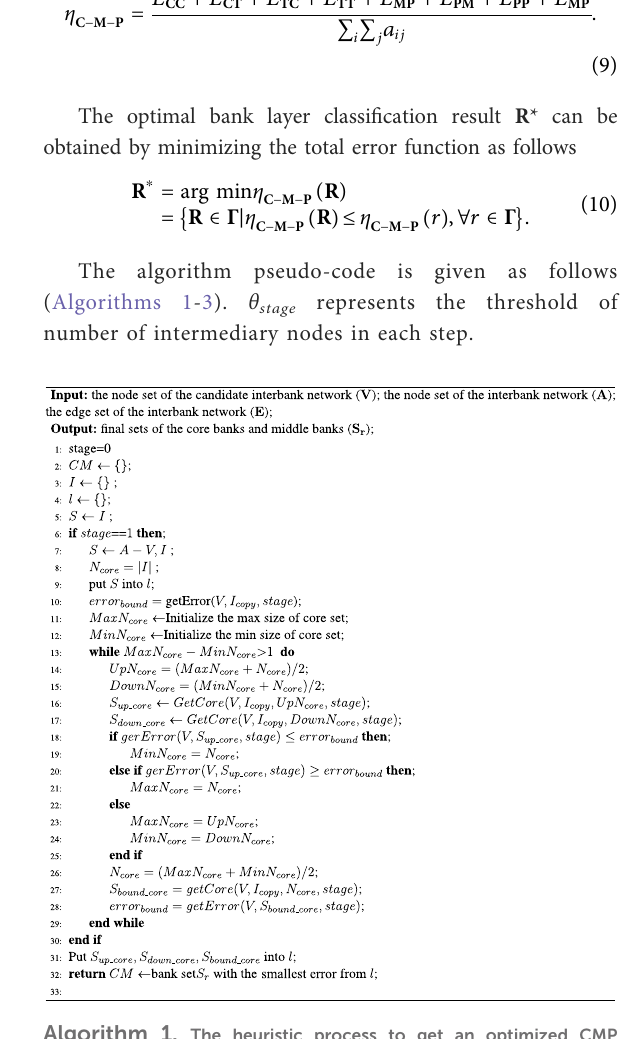
Algorithm 1. The heuristic process to get an optimized CMP